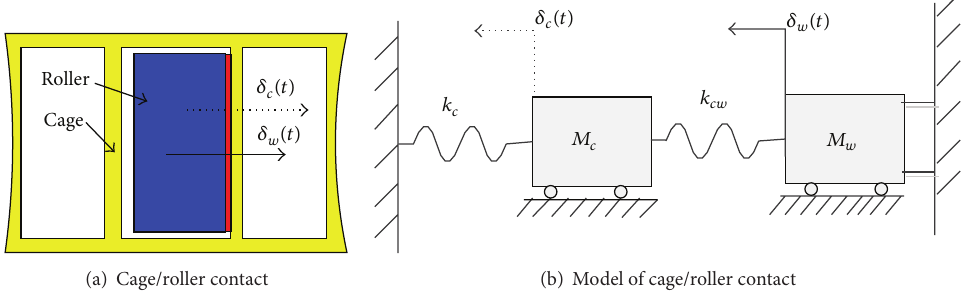
Figure 4: A 2-DOF model of cage/roller contact of the 𝑗 th roller.